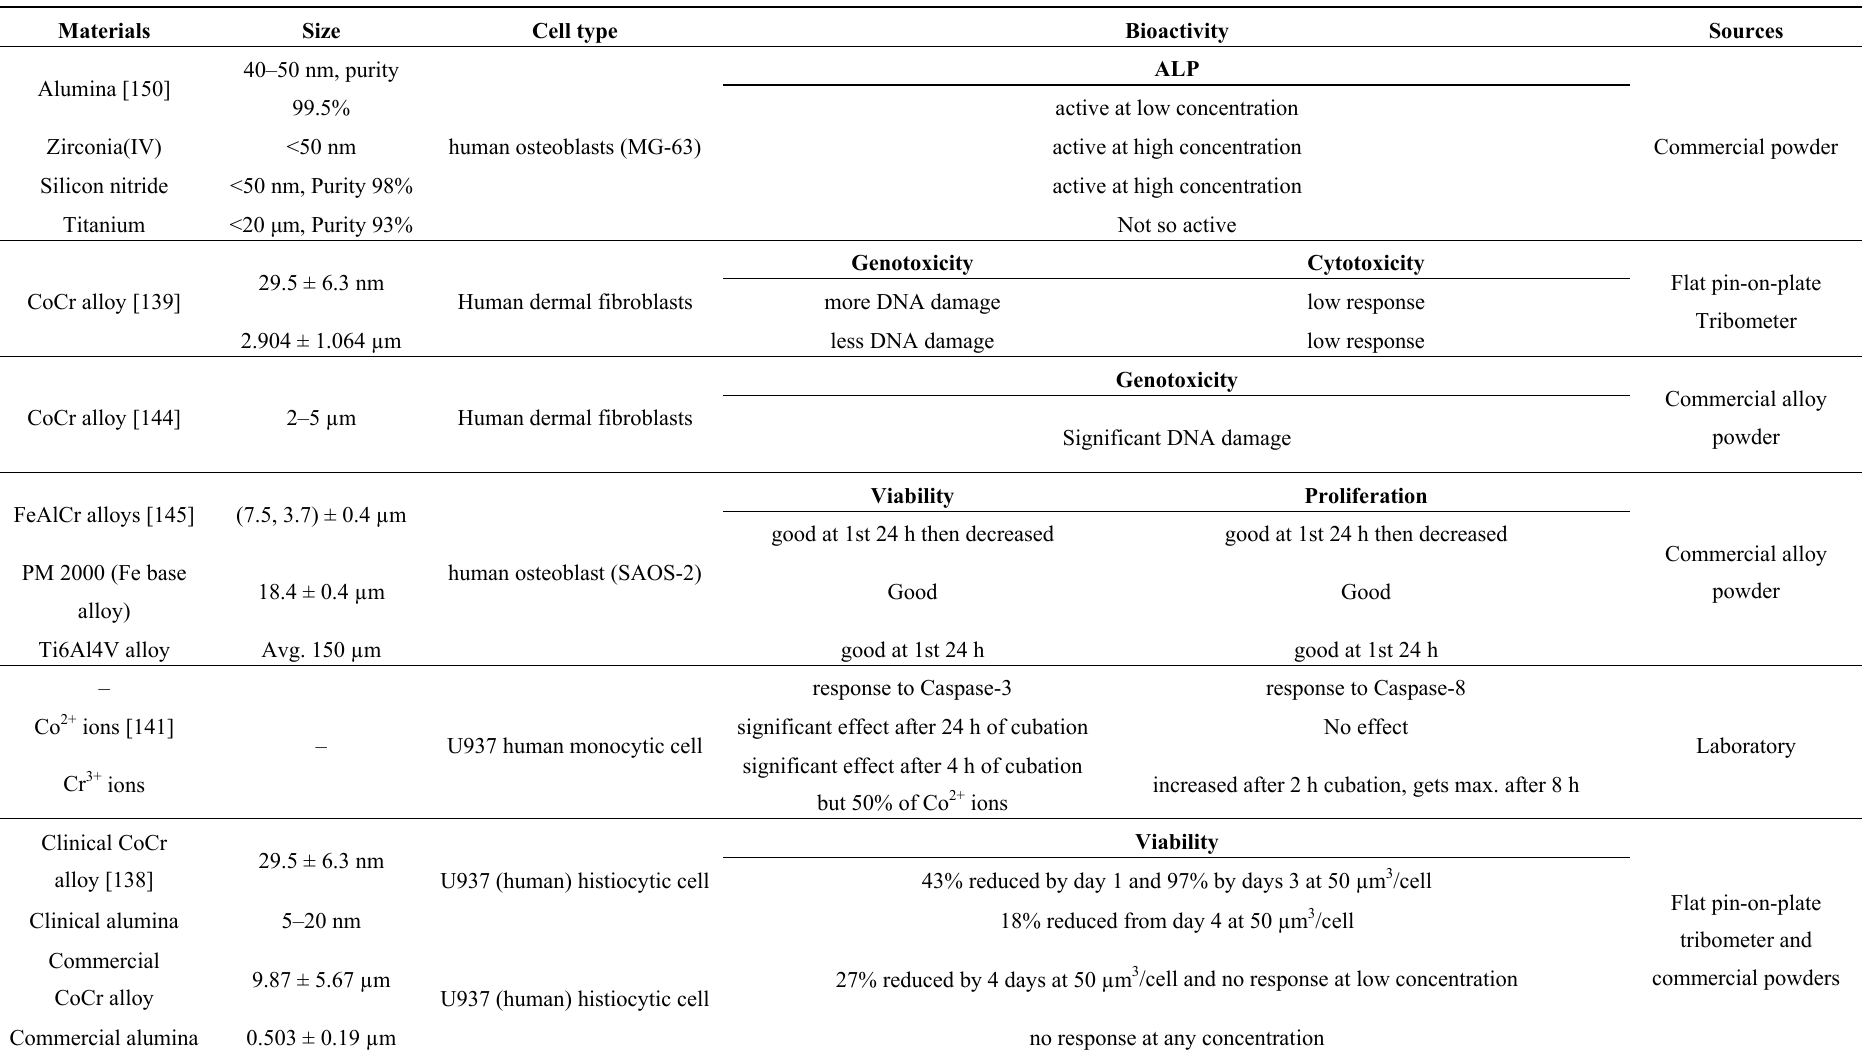
Table 4. Biological response of wear debris on human